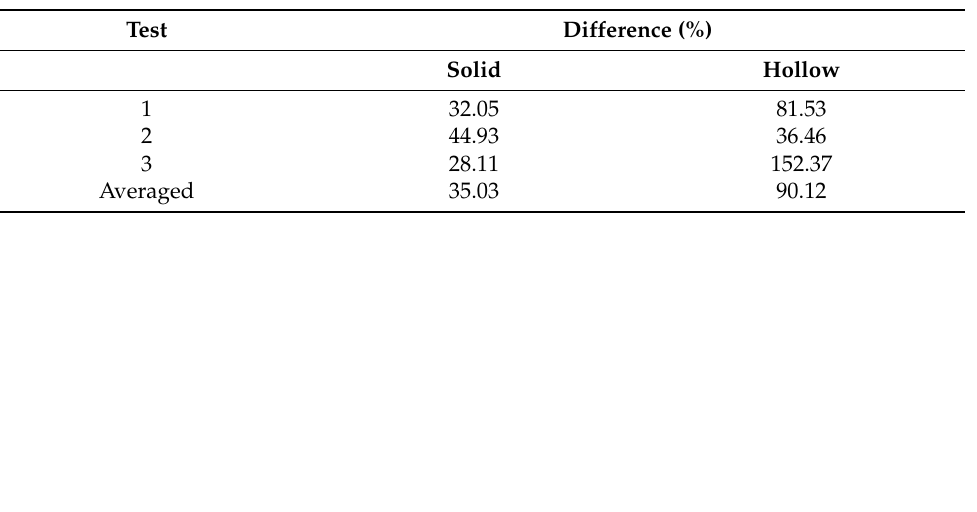
Table 3. Difference (relative to 0 s for each condition) for oval–shaped